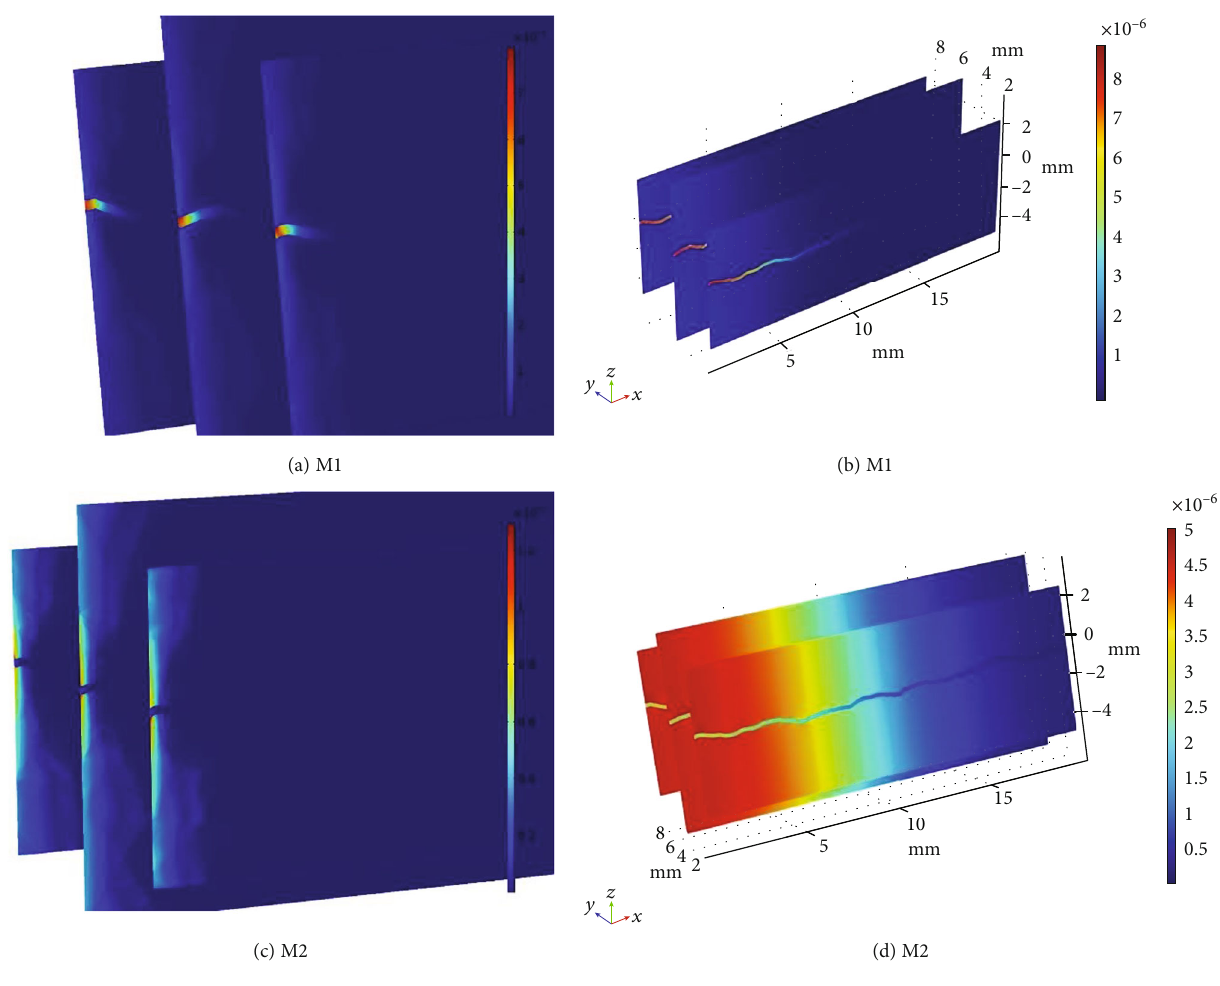
Figure 12: Distribution of the fl ow